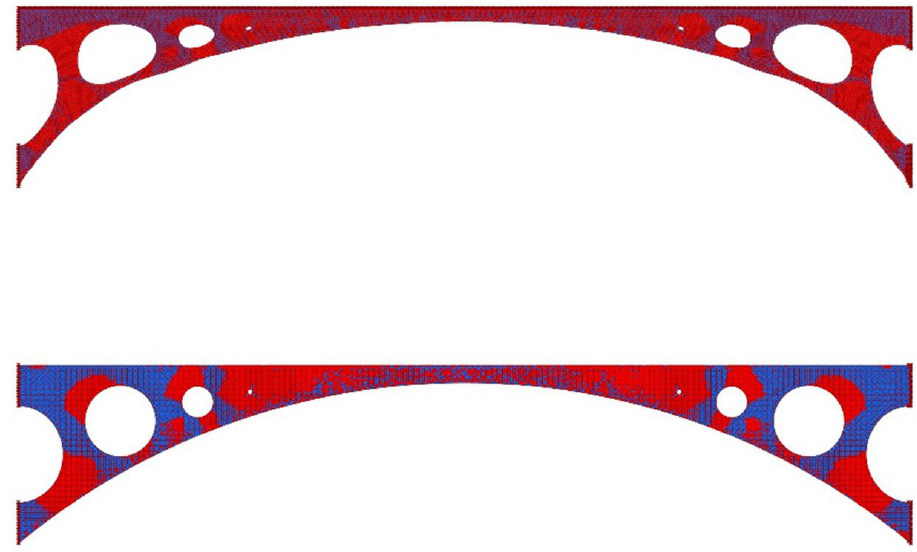
Figure 23. Comparison between shape-optimization result (bottom) and Kangaroo Solver.